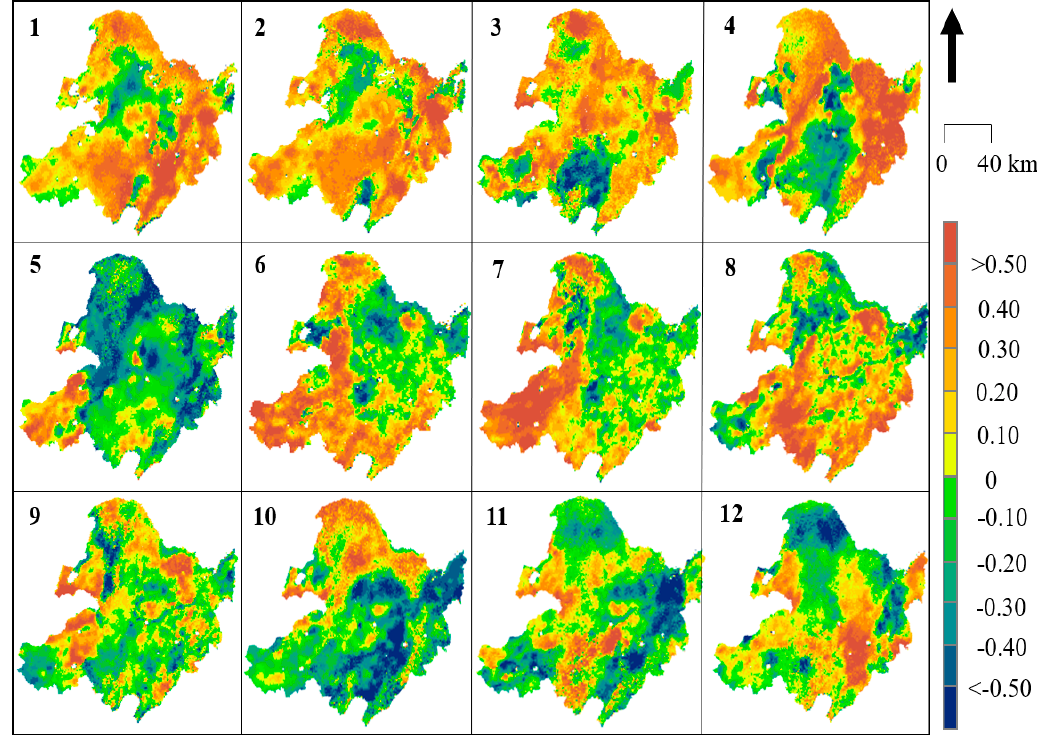
Figure 9. Trends in R for the mean monthly downscaled nighttime SM from 2002 to 2018 in NEC.